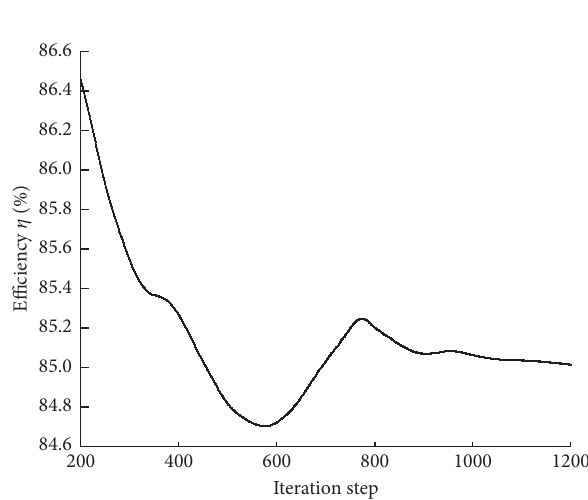
Figure 4: Efficiency curve with iteration step.